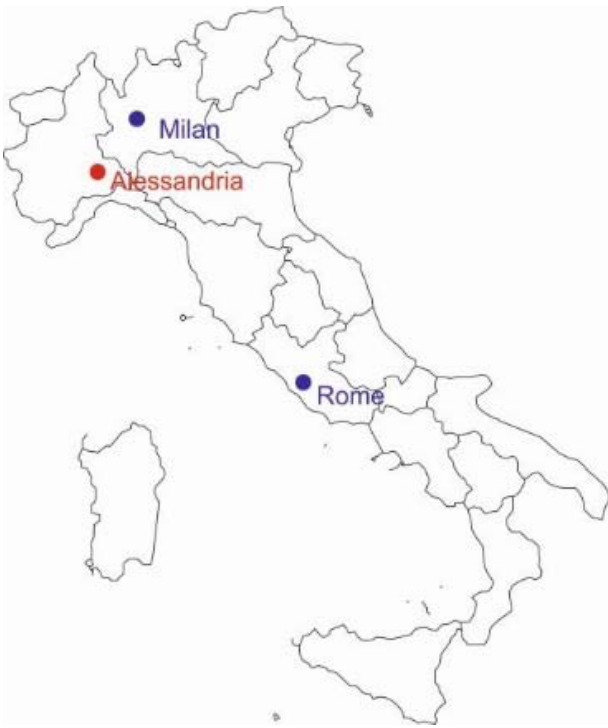
Figure 1. Localization of the study area.